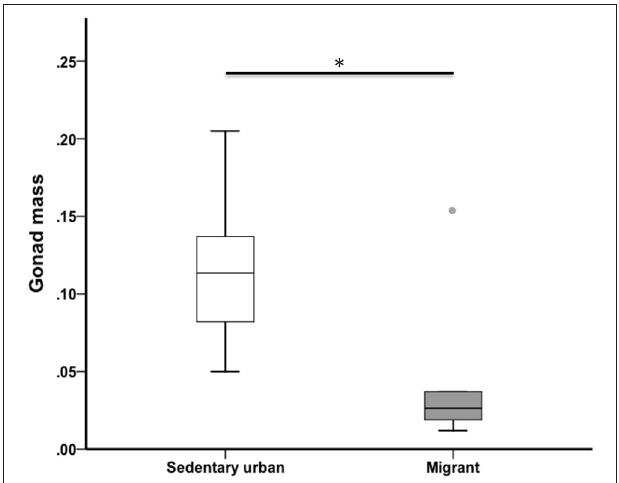
FIGURE 3 | Testis mass of male sedentary urban juncos was higher than that of migrant juncos in early spring. Boxes represent upper quartile, median, and lower quartile (* p ≤ 0.05). Whiskers include the range of values except for outliers. Outliers include values > 1.5 box lengths (circles).